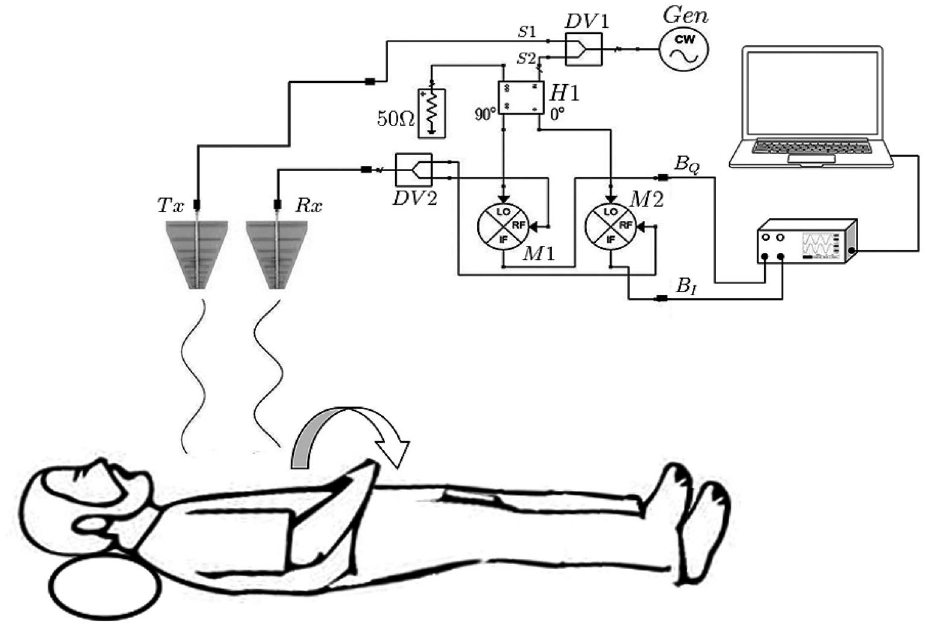
Figure 1. Experimental setup consisting of Quadrature Doppler radar, data acquisition system, and computer illustrating the relative location of antenna, and